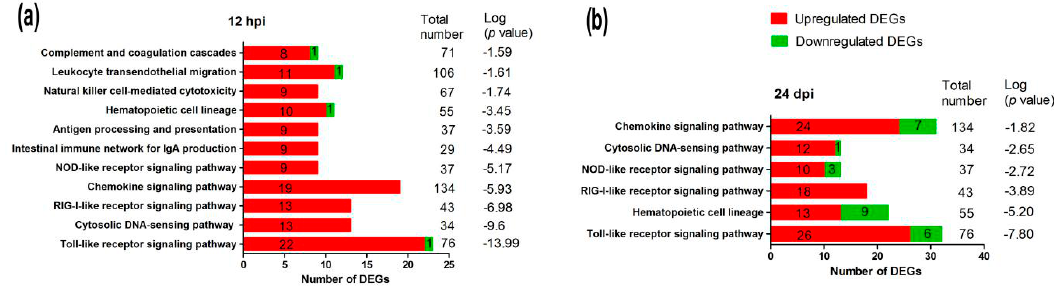
Figure 6. The immune system pathways enriched during duck Tembusu virus infections at 12 h ( a ) and 24 h ( b ) post-infection (hpi) ( p < 0.05).